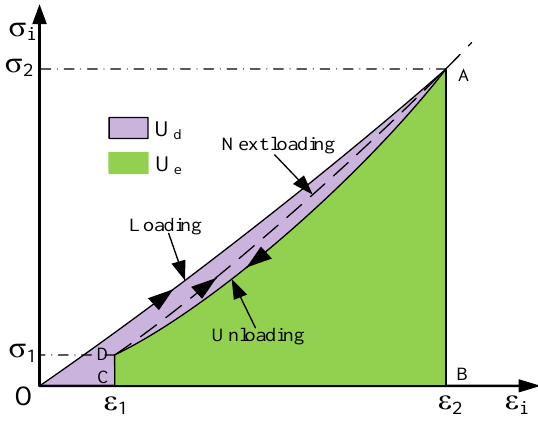
Figure 9. Relationship between the dissipated energy and elastic release energy of CRC specimens during cyclic loading and unloading.